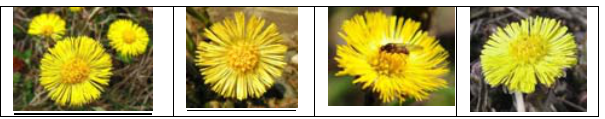
Figure 3: Coltsfoot (Source: Stitz, 2014).